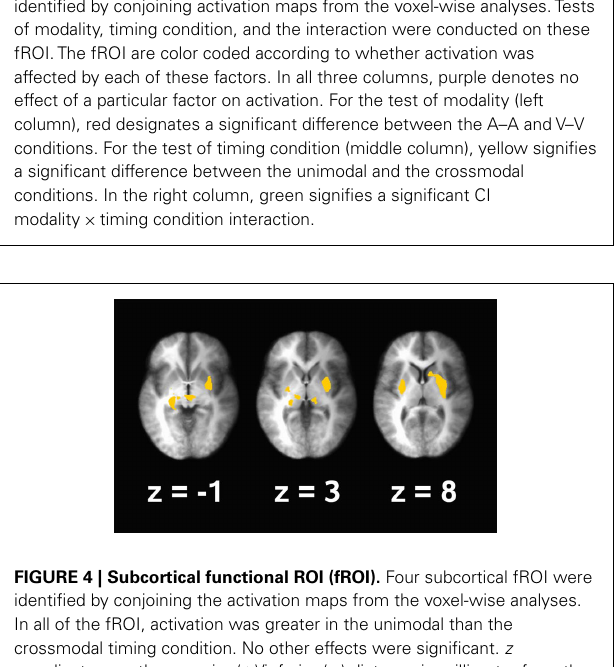
(MTG), parahippocampus, hippocampus], and middle-occipital cortices, the thalamus (pulvinar nucleus, lateral geniculate